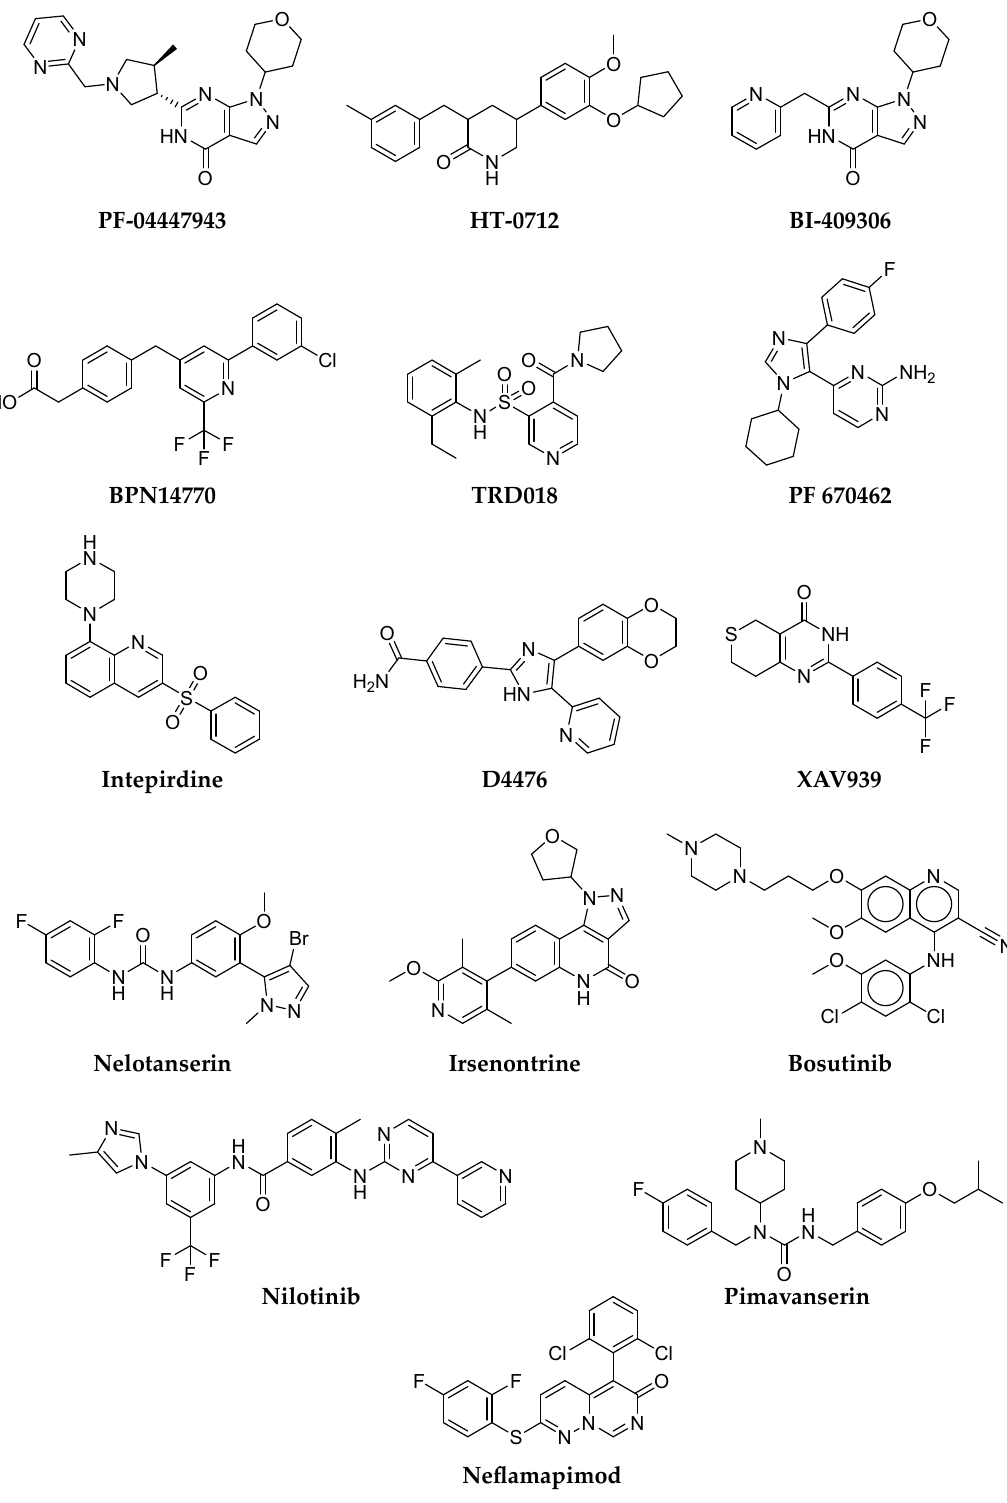
Figure 7. Structures of small molecule drug targets for AD, LBD, FTD, and VD.